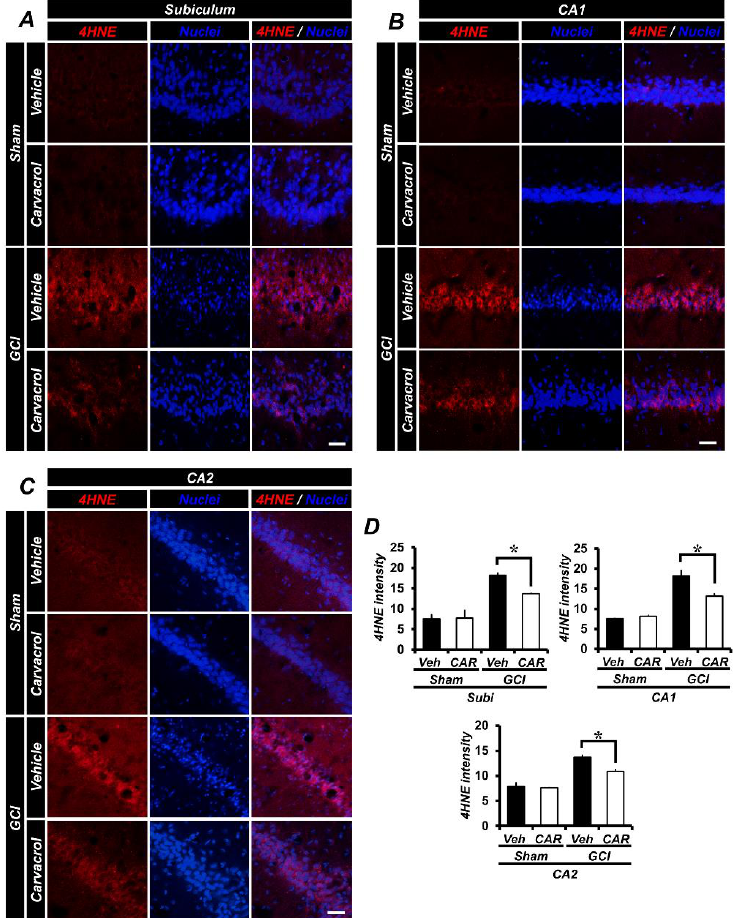
Figure 2. GCI-induced hippocampal oxidative damage was evaluated by 4-hydroxy-2-nonenal (4HNE; red signal) staining, counter-stained with 4’,6 -diamidino-2-phenylindole (DAPI; for detecting nuclei; blue signal) at the hippocampal subiculum, CA1, and CA2 regions (sham vehicle: n = 5; sham carvacrol: n = 4; GCI vehicle: n = 5; GCI carvacrol: n = 5). ( A – C ) The sham-operated groups displayed a minimal 4HNE fluorescence signal in the hippocampal subiculum, CA1, and CA2 regions. The 4HNE fluorescence red signal was outstandingly increased in the GCI vehicle group. This signal was